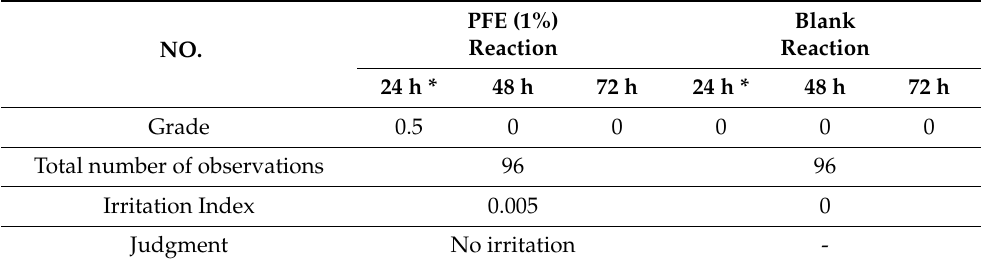
Table 3. Results of the human skin primary irritation